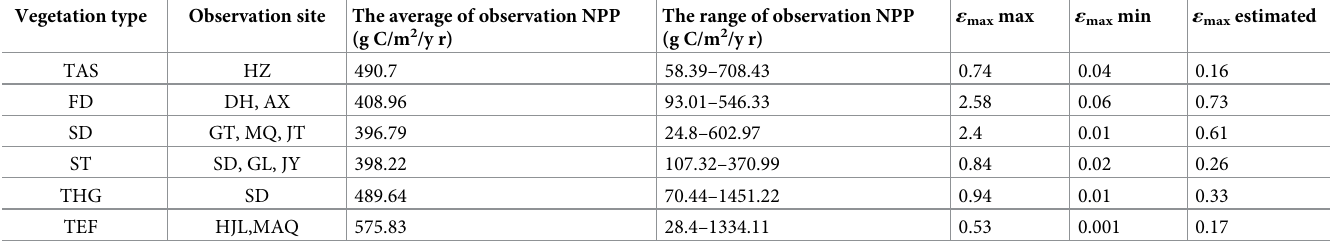
Table 1. The simulation value of the maximum light utilization rate( ε max ) of Gansu. Vegetation type Observation